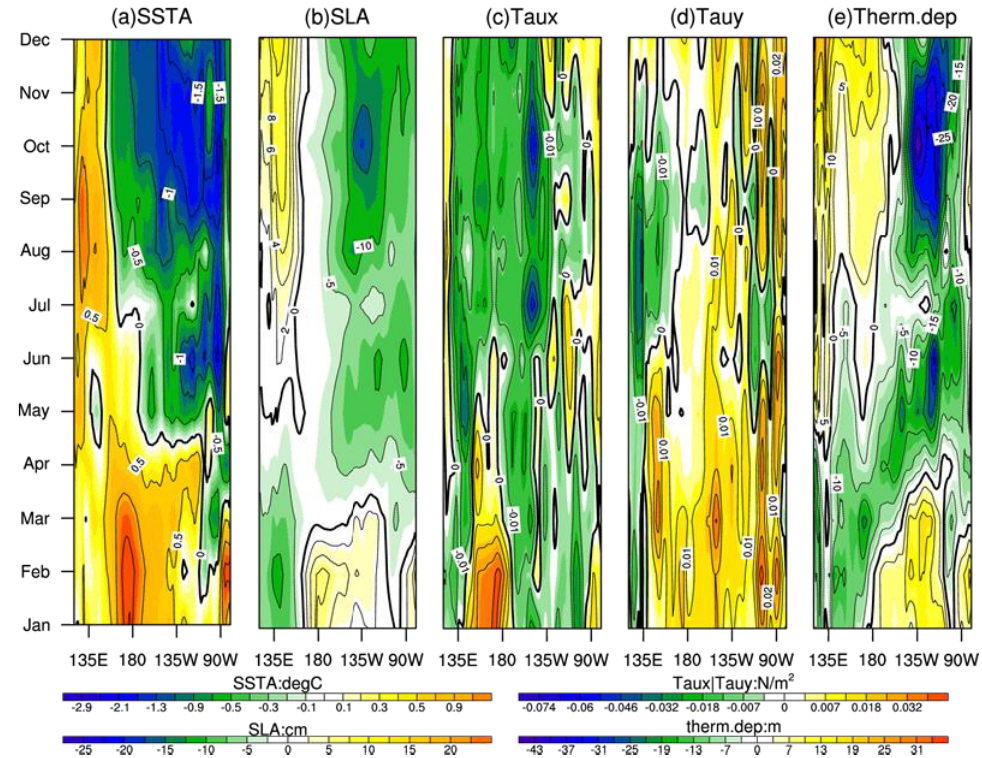
Figure 1. Zonal-time sections along the equatorial Pacific (averaged at 2° S − 2° N) for anomalous ( a ) SST, ( b ) SL, ( c ) Taux, ( d ) Tauy, and ( e ) thermocline depth in 2020.